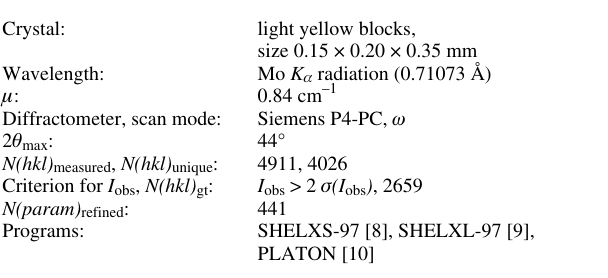
Table 1. Data collection and handling.